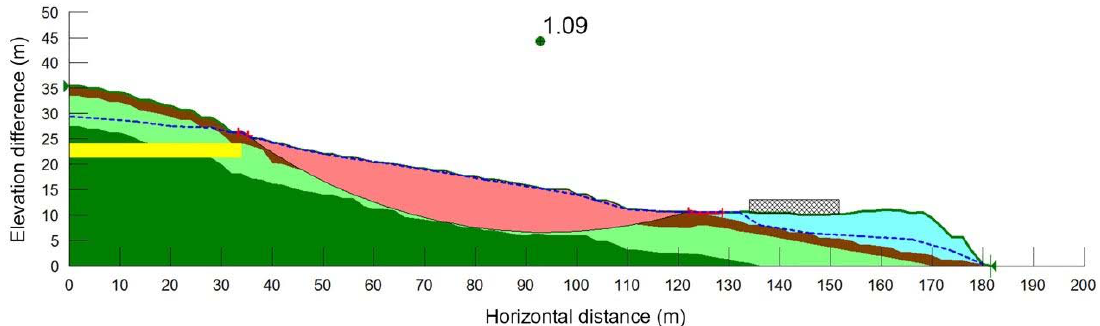
Figure 13. Area unstable (pink) assuming locals of entrance and exit of the surface of rupture and residual shear strength parameters for degraded marls. Blue dashed line represents water table.